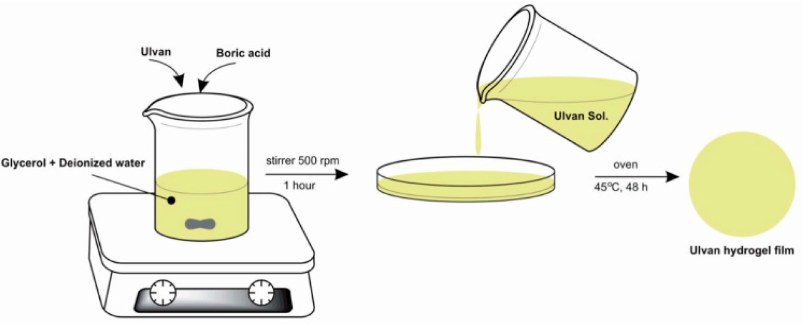
Figure 7. Method of ulvan hydrogel films obtaining (adapted from Sulastri et al., 2021, [196]). Ulvan-based hydrogels, respectively UMA-based (ulvan methacrylate) hydrogels, conditioned as 3D polymeric networks were developed for a different application, bone tissue regeneration. Dash et al., 2014, reported that the enzymatic deposition of some apatite crystals led to a homogeneous distribution on the scaffold surfaces and represents one of the processes that could elicit the osteoblast cells proliferation and differentiation